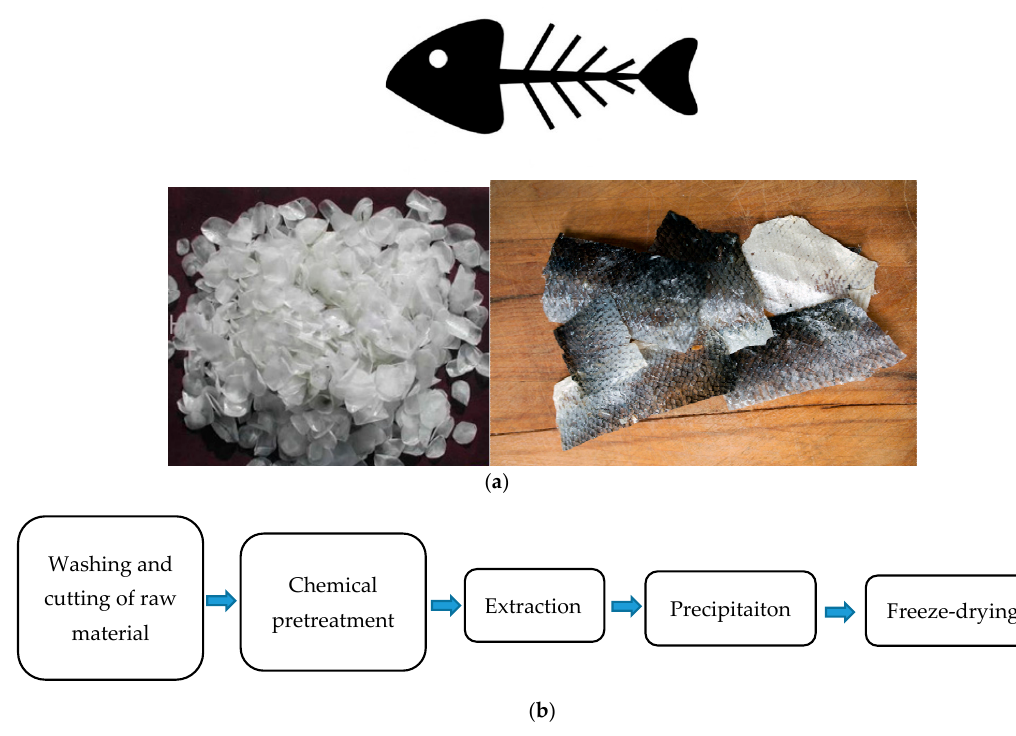
Figure 2. ( a ) Fish bone, scales, and skin as sources of collagen. ( b ). Collagen extraction procedure from fish